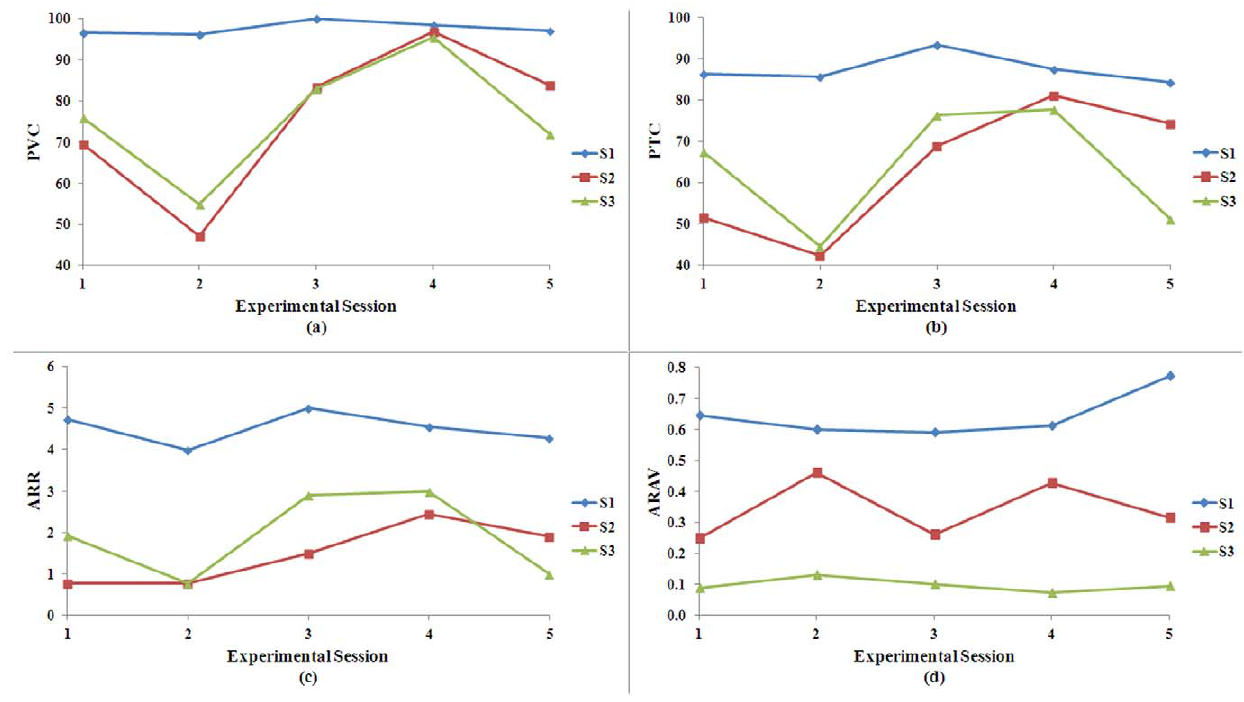
Figure 5. Performance quality metrics. (a) Percent valid correct (PVC) is the ratio of total hits to total non-invalid attempts during each experimental session. (b) Percent total correct (PTC) includes invalid attempts in the calculation. (c) The average number of rings obtained per reset (ARR) is a metric of control continuity. (d) The average ring acquisition velocity (ARAV) is the average of the net distance travelled by the helicopter from ring presentation to acquisition divided by the time required to cover the distance. ARAV serves as a control speed